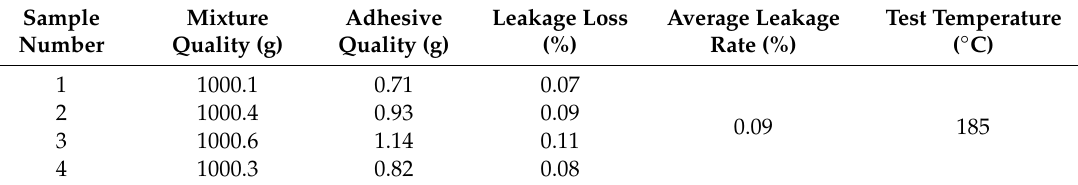
Table A4. The leakage test results of Novachip-B.